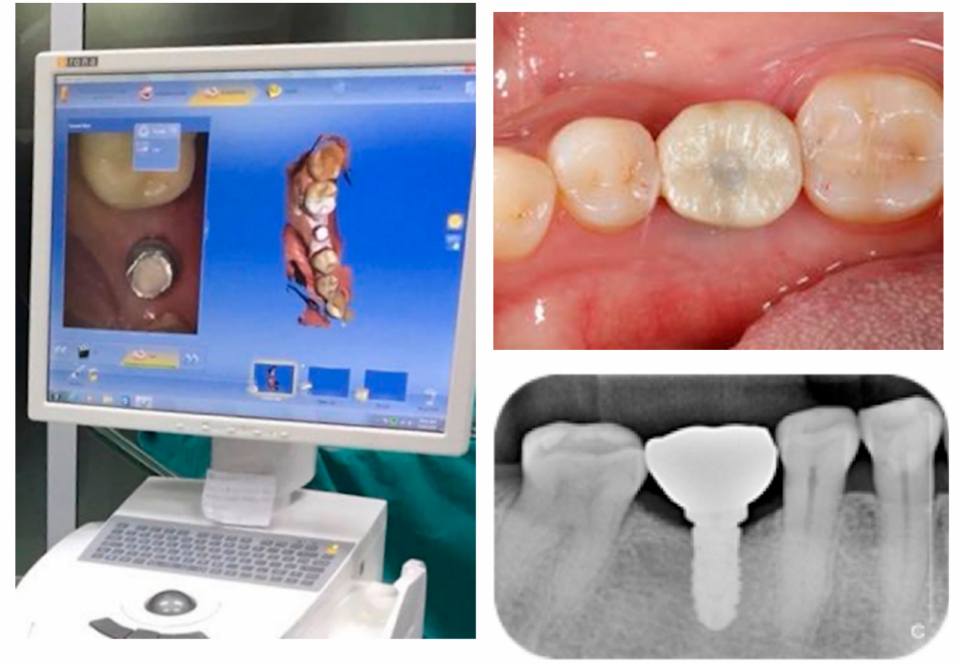
Figure 2. Shows intraoral scanning with CEREC AC Connect with CEREC Omnicam (Dentsply Sirona ® , York, PA, USA).